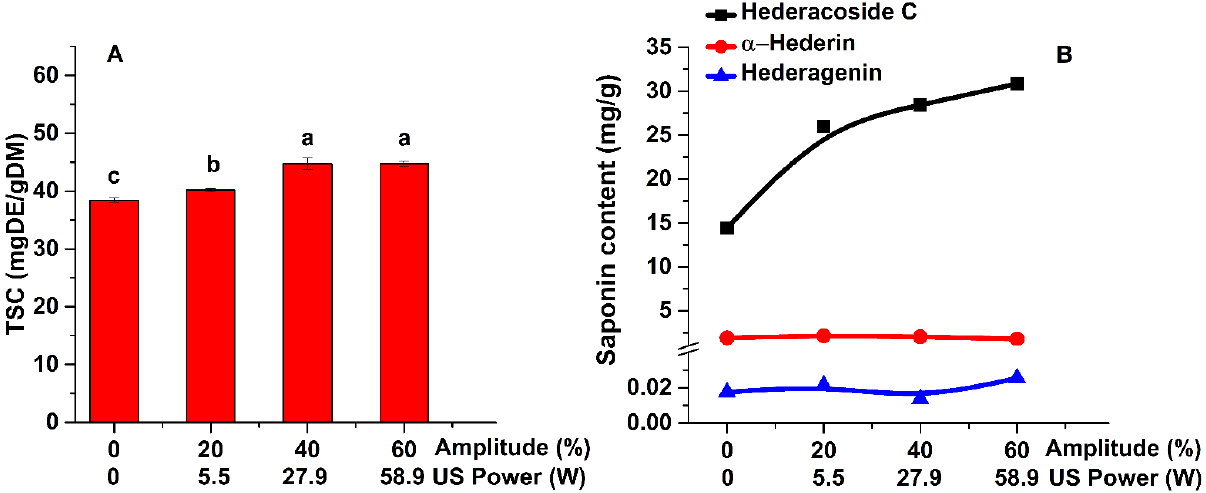
Figure 1. Influence of ultrasonic power on the TSC ( A ) and on the main saponins ( B ) of Hedera helix leaves extracts (extraction conditions: a temperature of 30 °C, an extraction time of 60 min, a plant material to solvent ratio of 1:20 (w:v), continuous sonication, an ethanol concentration of 96%). Data were analyzed using one-way ANOVA ( p < 0.05) and multiple comparison post hoc t -tests (n = 6). Different letters (a–c) within graph shows the significant difference between groups.